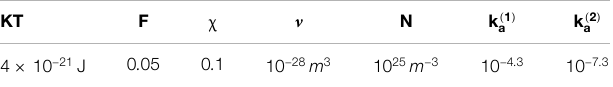
TABLE 1 | The material parameters of poly (HEMA-co-DMAEMA) and poly (HEMA-co-AA) pH-sensitive hydrogel (Marcombe et al.,